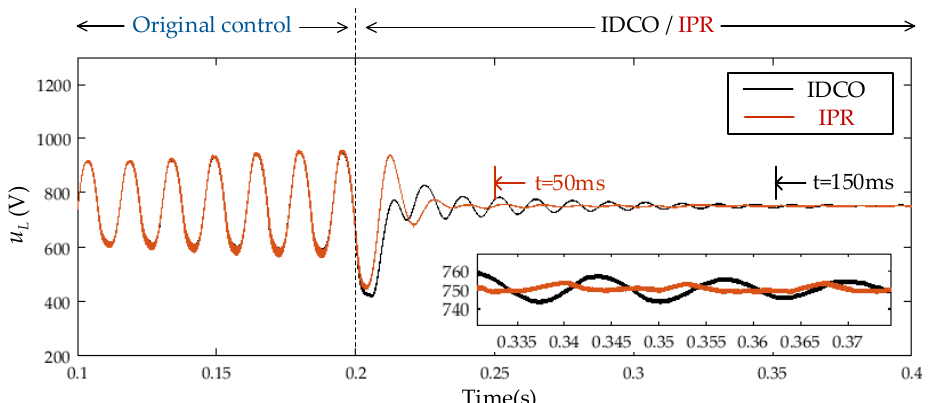
Figure 19. Damping results of the LV bus voltage u L . Figure 19 . Damping results of the LV bus voltage L u . Figure 19 . Damping results of the LV bus voltage